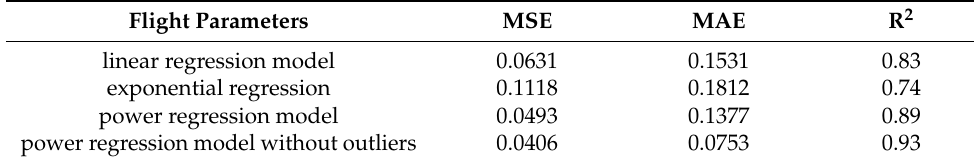
Table 2. Statistical measure results of different regress